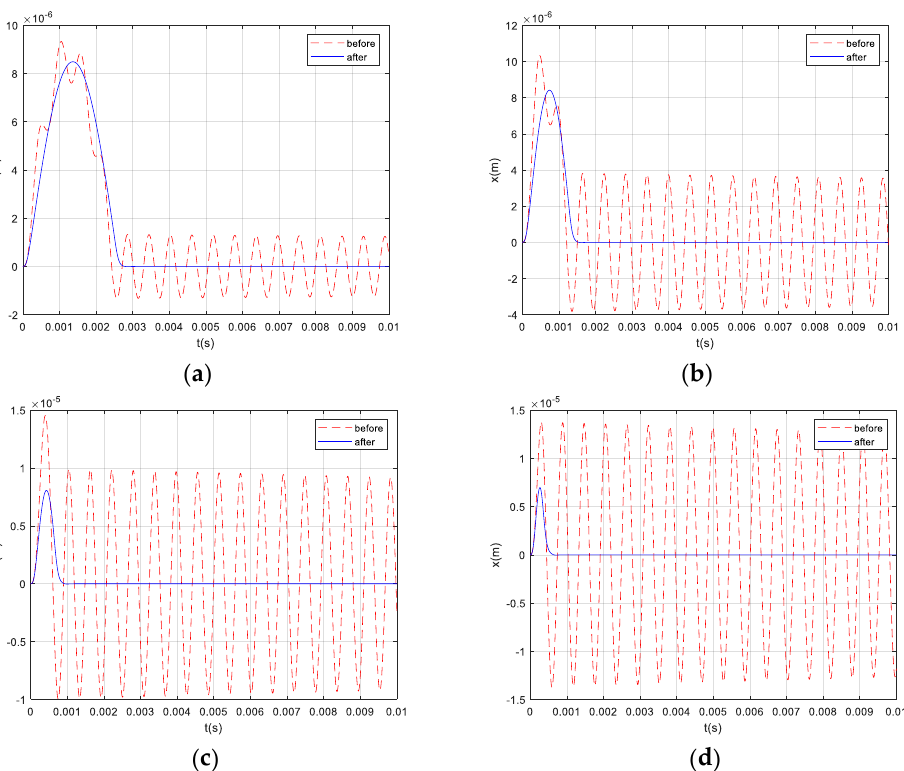
Figure 10. System shock responses before and after the introduction of the electrostatic active damp-